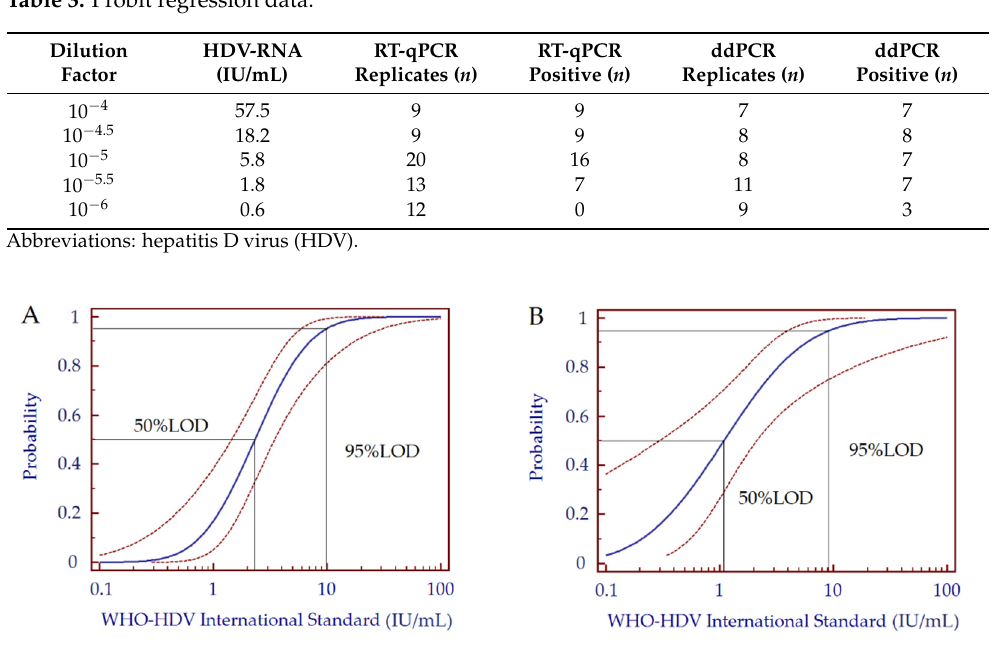
Figure 5. Probit analysis of HDV-RNA amplification data obtained by RT-qPCR assay ( A ) and ddPCR assay ( B ) for the estimation of the 95% and 50% limit of detection (LOD). Probit curves are depicted in blue; the two additional red dashed curves represent the 95% confidence interval for each probit curve. Abbreviations: hepatitis D virus (HDV); World Health Organization (WHO).